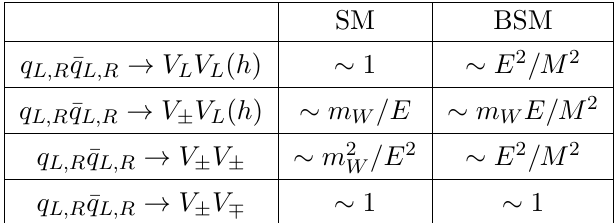
Table 1 . High-energy scaling of diboson amplitudes for transverse ( (cid:6) ) and longitudinal ( L ) polar- izations in the SM and in BSM (parametrized by d = 6 operators suppressed by 1 =M 2 ). of utmost importance. In section 2 we de(cid:12)ne the high-energy primaries through the above- mentioned classi(cid:12)cation, and we illustrate their connection with popular EFT operator bases and with the low-energy